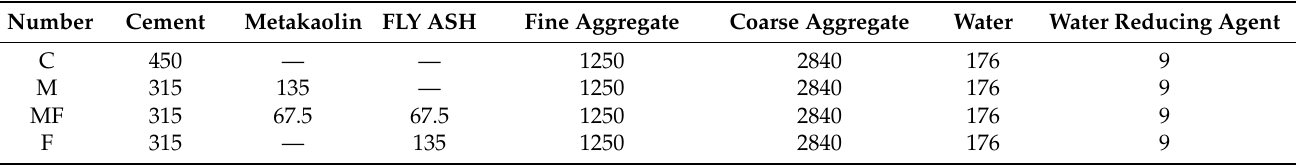
Table 2. Concrete mix